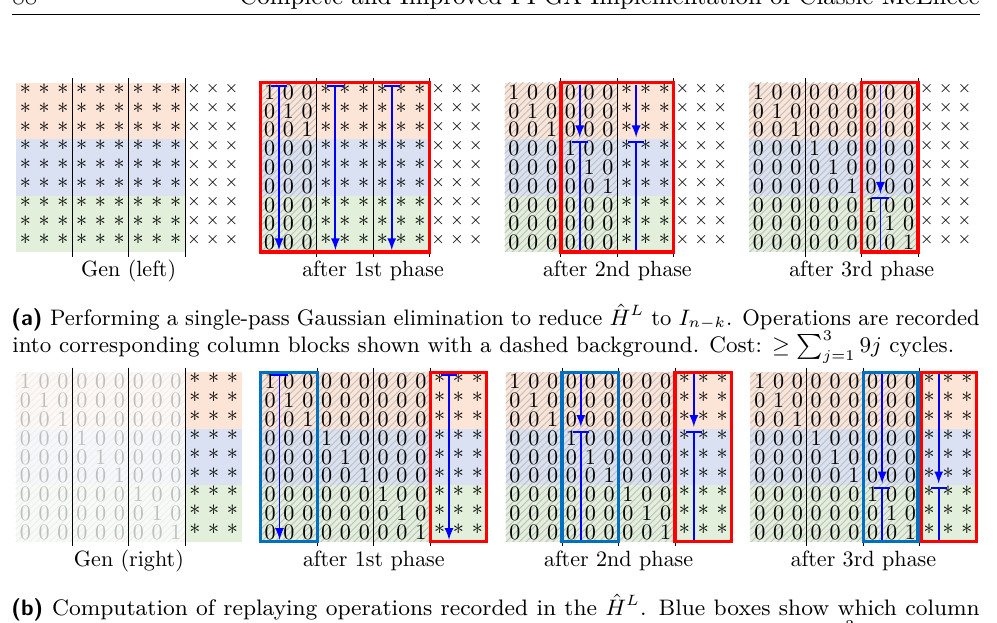
Figure 11: Visualization of SPEA for a 9 × 12 matrix using a column-block size of s = 3. Asterisks denote random data. Corresponding sets of rows are marked in the same color. Red boxes show which matrix parts have been computed. ‘Gen (right)’ denotes only ˆ H R is